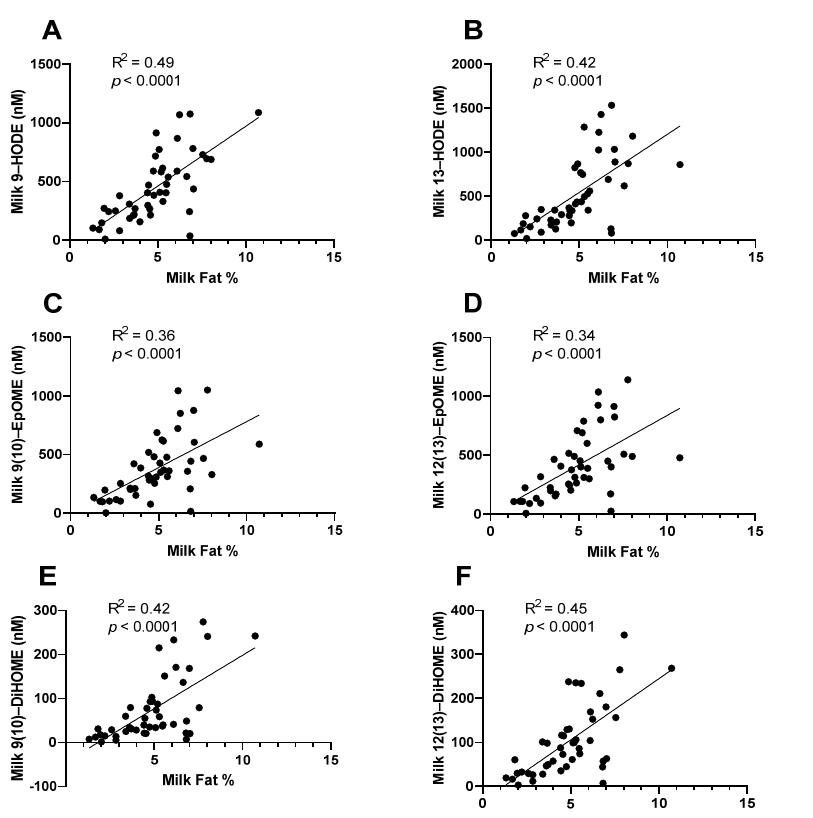
Figure 2. Total (esterified + non-esterified) oxylipins measured in whole milk are strongly correlated with total milk fat. Samples were collected as part of a case–control study of low milk supply. Most oxylipins, including the linoleic acid-derived oxylipins, ( A ) 9-HODE, ( B ) 13-HODE, ( C ) 9(10)-EpOME, ( D ) 12(13)-EpOME, ( E ) 9(10)-DiHOME, and ( F ) 12(13)-DiHOME, were strongly correlated with the total milk fat measured in the sample ( n = 46).